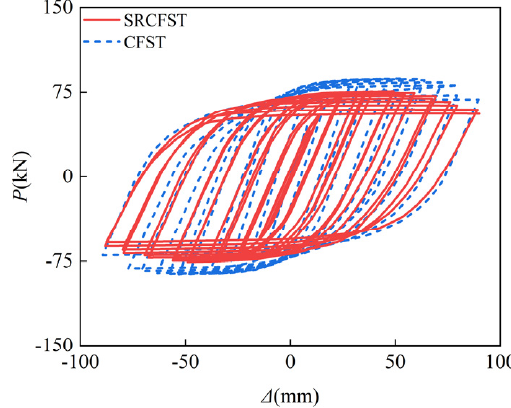
Figure 15. P - Δ hysteretic curves. Figure 15. P - ∆ hysteretic